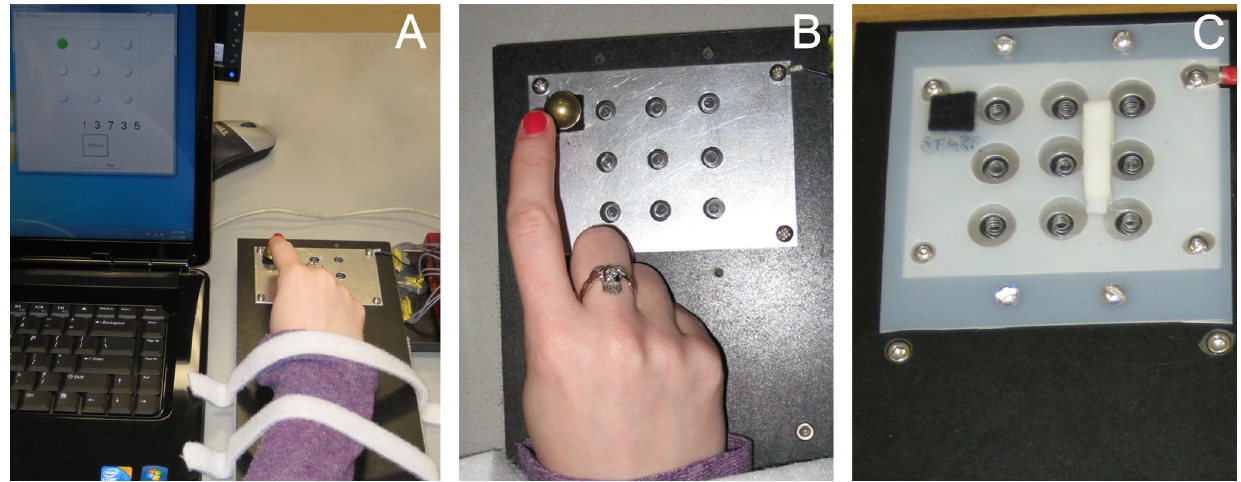
Figure 2. The Marble Navigation Task used to measure skilled motor learning. (A) Participants view the computer screen to see where to move the marble. (B) The MNT board used for week 1. (C) A novel version of the same MNT board was used for week 2.